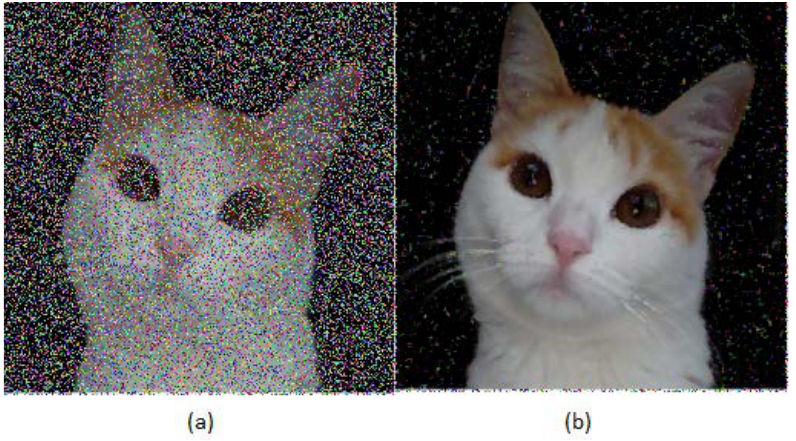
Figure 7. ( a ) The Vicky cat image deciphered with 40% occlusion noise, and ( b ) deciphered with noise and then median filter is applied. Table 14. SP parameter for distinct noise size of the testing images after encryption, utilizing chi square